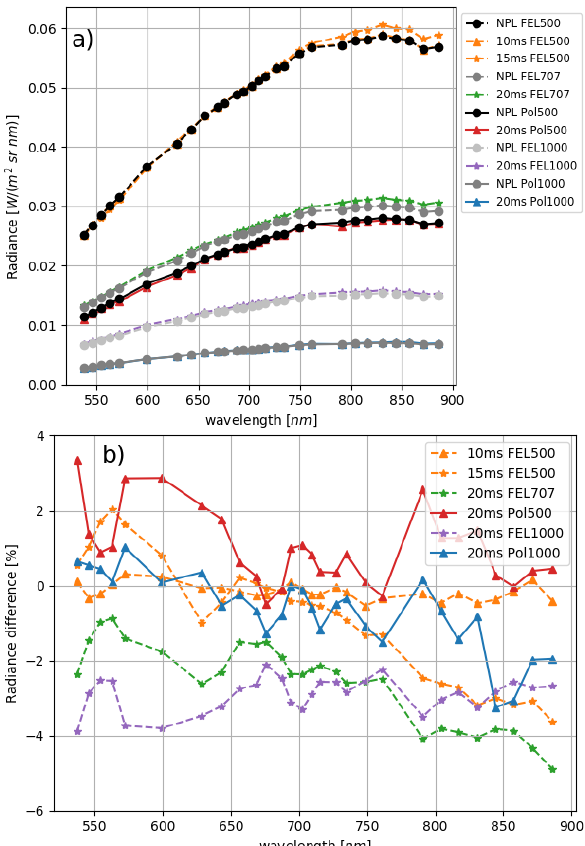
Figure 4. a) New adjusted radiance spectra L New (FEL500, FEL707, FEL1000, Pol500 and Pol1000) and NPL reference radiance L NPL_ref (NPL) b) percentage difference to NPL reference L NPL_ref for six independent data